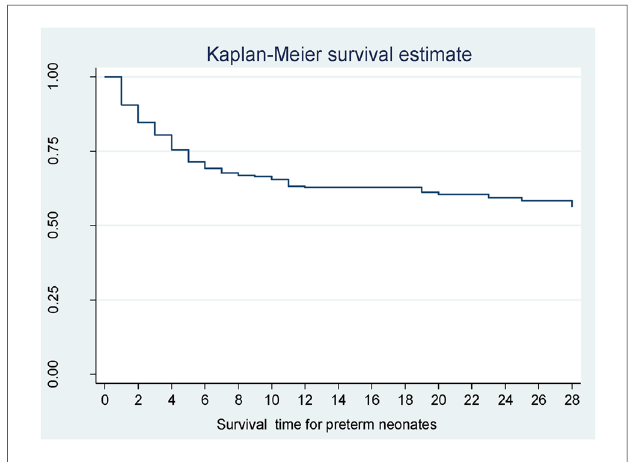
FIGURE 2 Overall survival function for preterm neonates in Northern Ethiopia, between February 1, 2017, and January 30, 2022 ( n